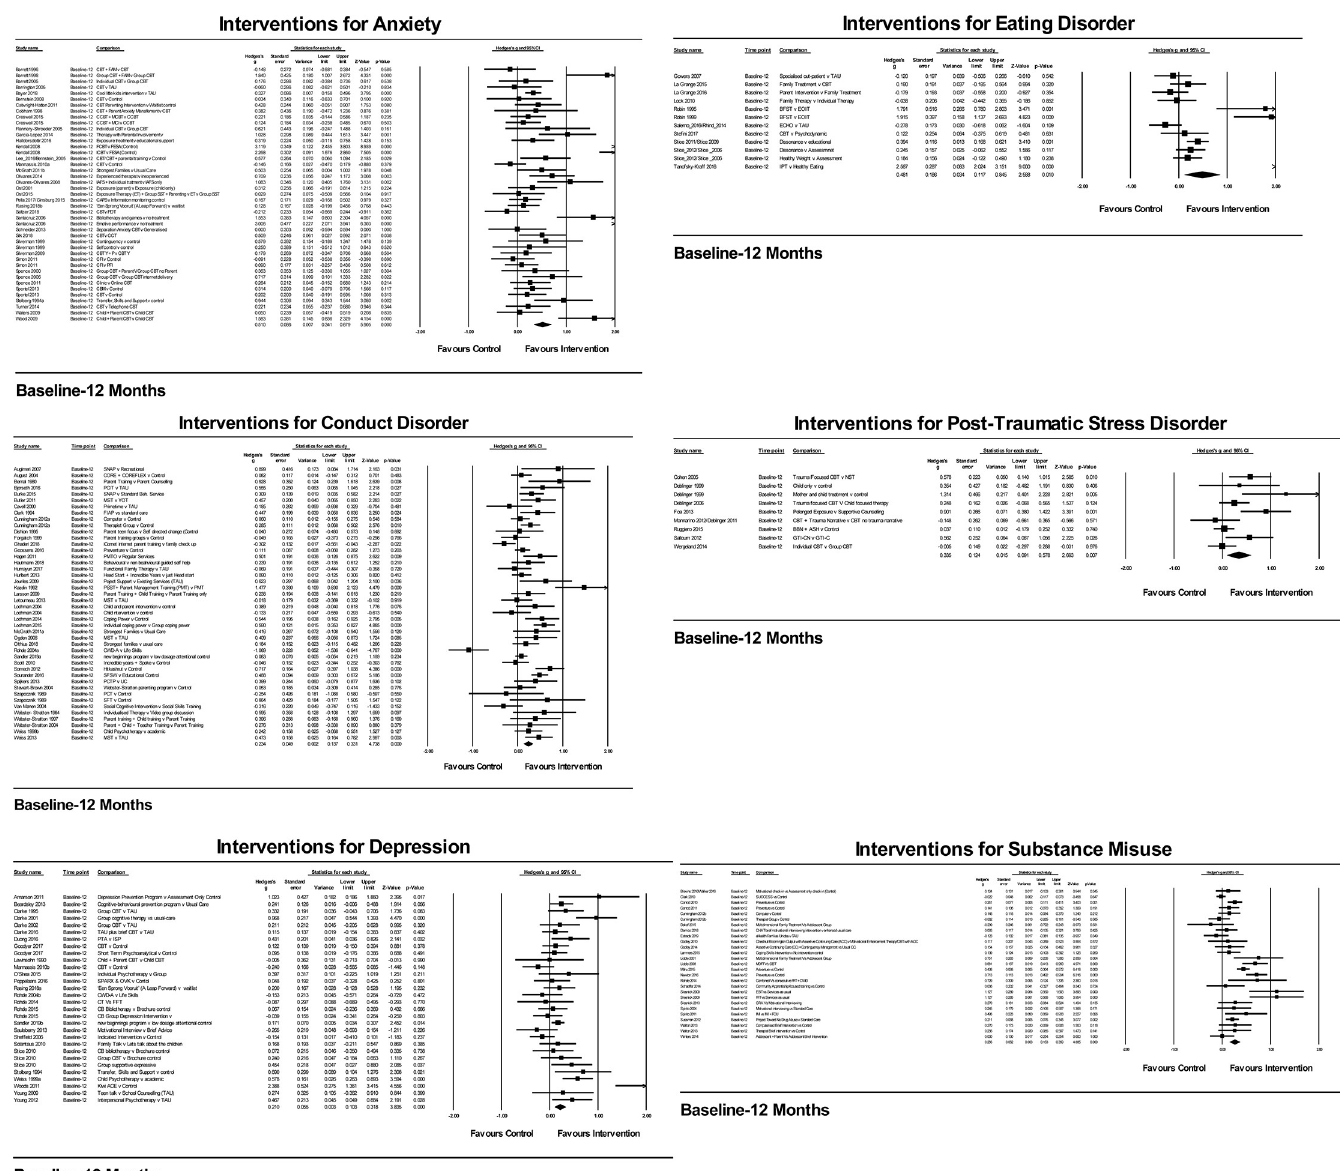
Fig 2. Effects of interventions for each disorder at 12-month follow-up. Where data was nominal, event counts have been added to the change score columns. Where only effect sizes were available, standardized mean differences (d) or odds ratios (OR) were added to the change score columns.